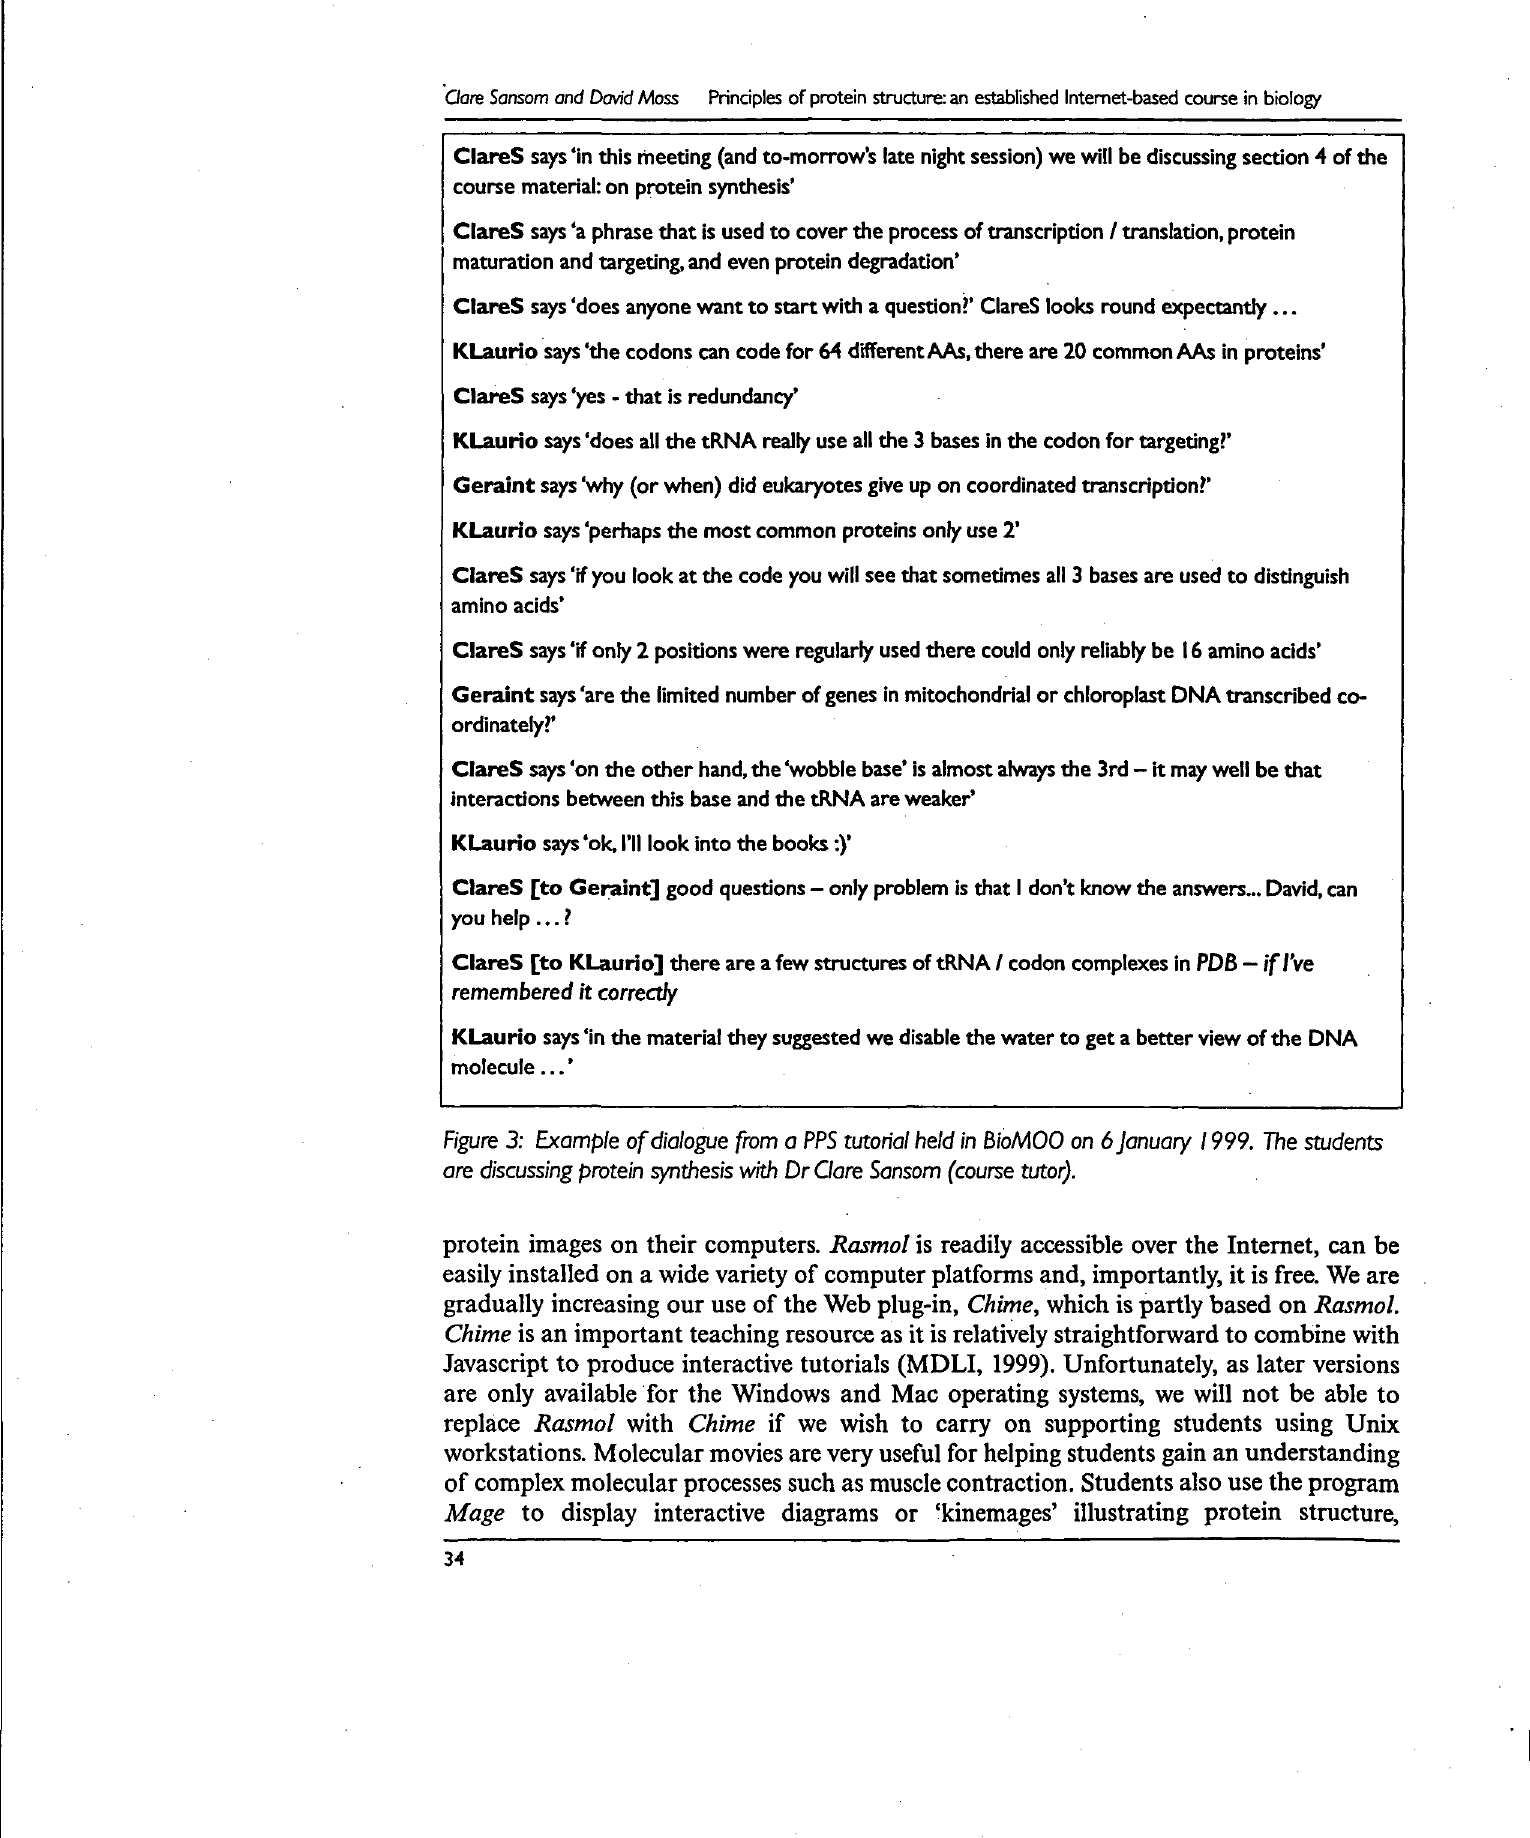
Figure 3: Example of dialogue from a PPS tutorial held in BioMOO on 6 January 1999. The students are discussing protein synthesis with Dr Clare Sansom (course